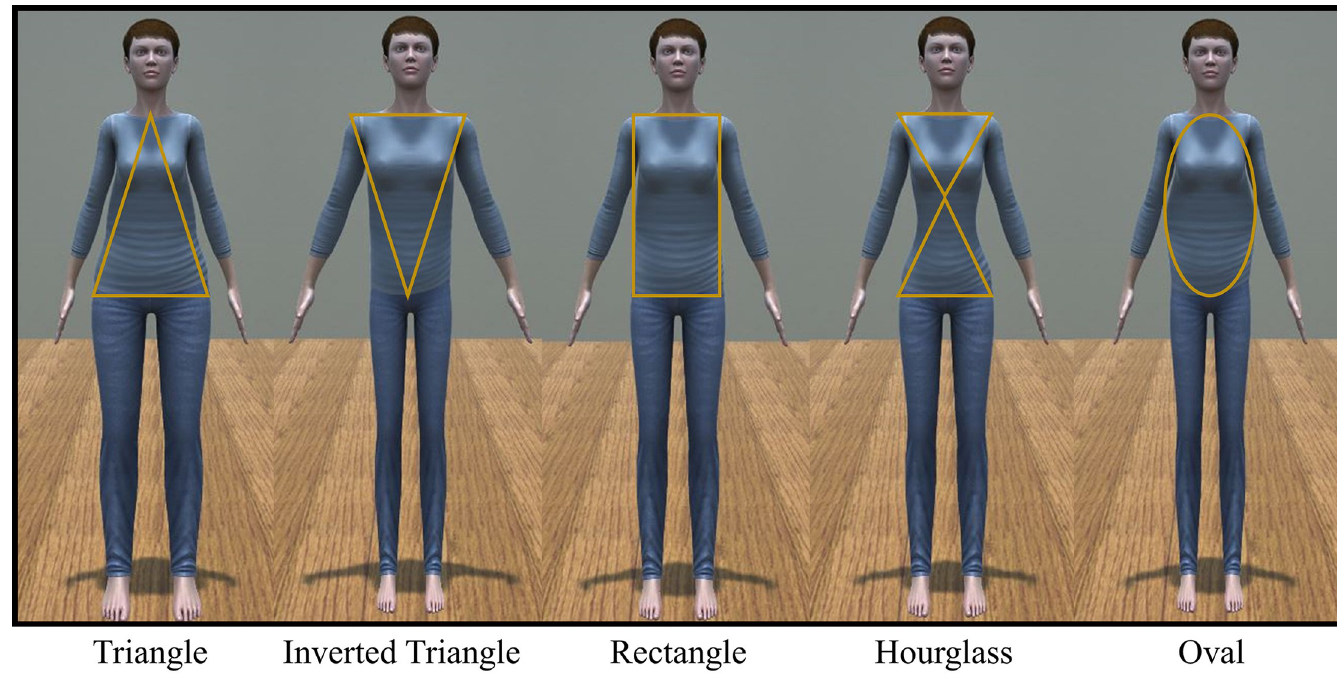
Fig 2. Examples of female avatars with different body